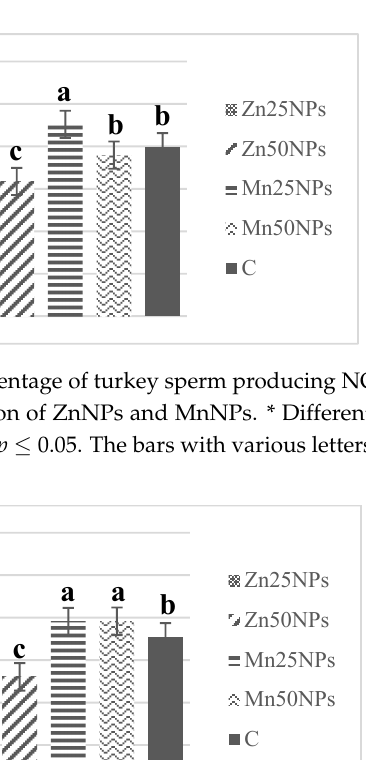
(C) the addition of ZnNPs and MnNPs.